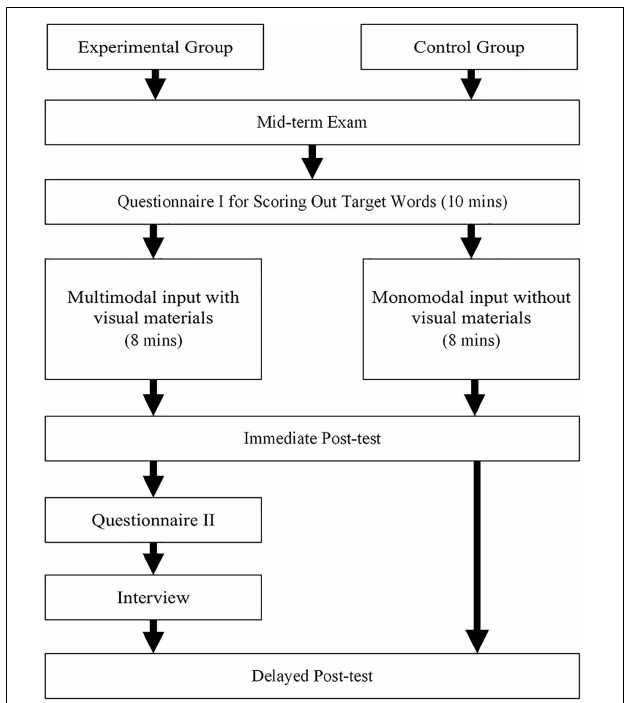
FIGURE 2 | Experimental procedures.